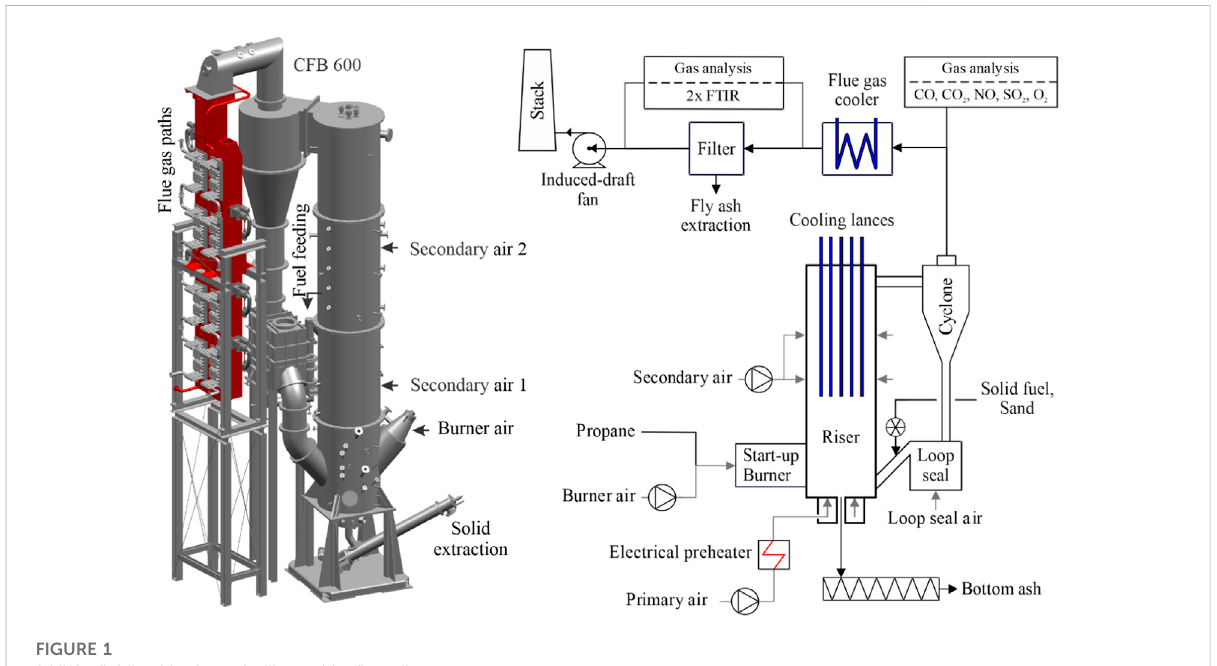
FIGURE 1 1 MW th fl uidized bed test facility and its fl ow diagram.